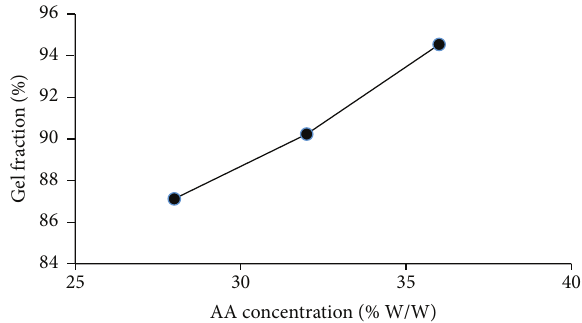
Figure 10: Effect of acrylic acid concentration on gel fraction of AA/Gelatin hydrogels.